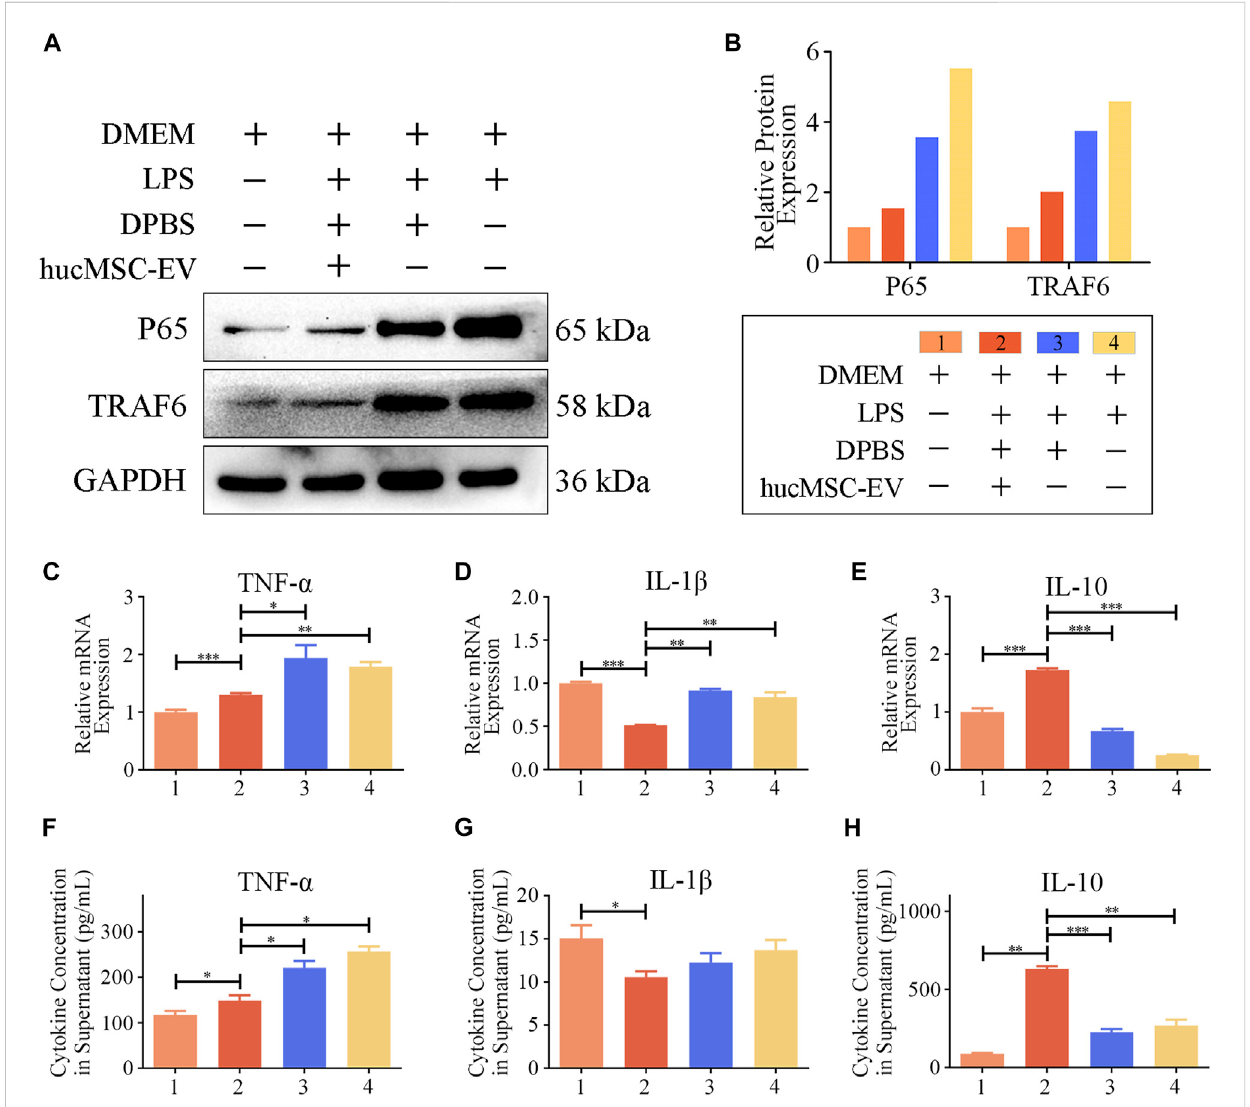
FIGURE 6 hucMSC-EVregulatep65,TRAF6,andcytokinetranscriptionandexpression. (A,B) Representativewesternblotsofp65andTRAF6inRAW264.7cells fromeachgroup (A) andtherelativeproteinexpression (B) ;bandintensitieswerenormalizedagainstthecorrespondingGAPDH. (C – E) mRNAexpression levelsofcytokinegenesinRAW264.7cellstreatedwithLPSfor8 handhucMSC-EVfor12 h( n =3). (F – H) Concentration ofcytokinesTNF- α (F) ,IL-1 β (G) , and IL-10 (H) in the culture supernatant of RAW264.7 cells treated with LPS for 8 h and hucMSC-EV for 48 h ( n = 4). Data are expressed as the mean ± SD. Statistical signi fi cance was determined using one-way ANOVA followed by an unpaired t-test or Kruskal – Wallis test. * p < .05, ** p < .01, *** p <